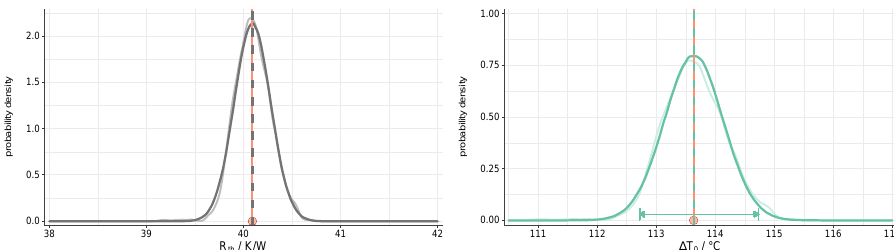
Figure 8. ( Left ) Posterior marginal of the thermal resistance R th for a single dataset of E1 ( n 2 = 100, Issue 1); ( right ) posterior predictive distribution for the respective dataset with posterior mean (dashed line) and 95%-HPD region (arrows) of ∆ T 0 and true value (red